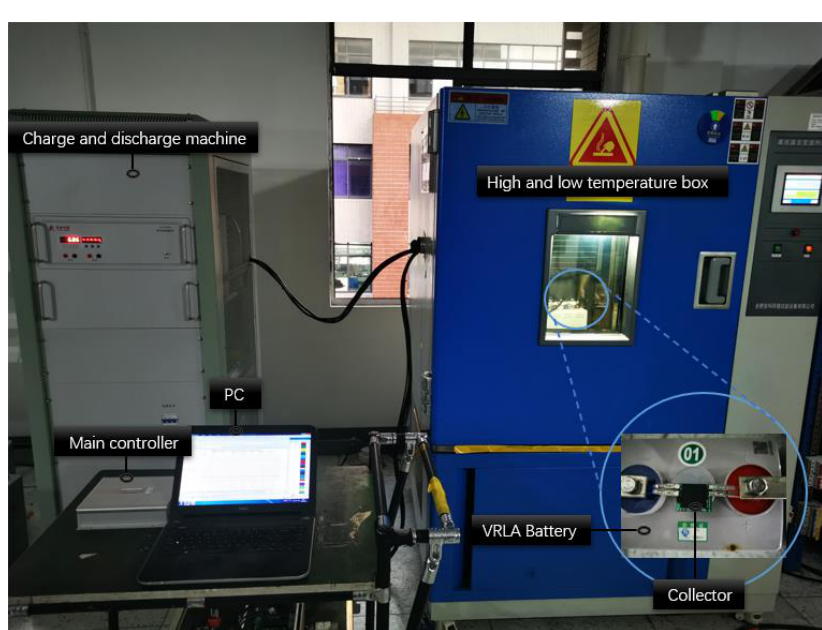
Figure 12. Picture of experiment and test site.